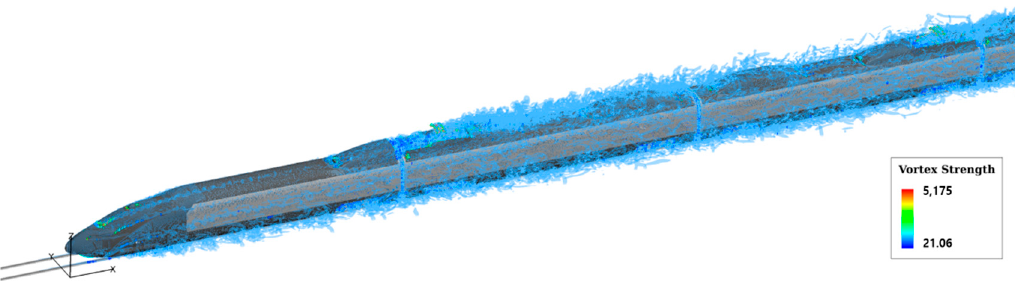
Figure 5. Instantaneous iso-surfaces of Q-criterion (=3,000) and vortex core with its strength of open field case.